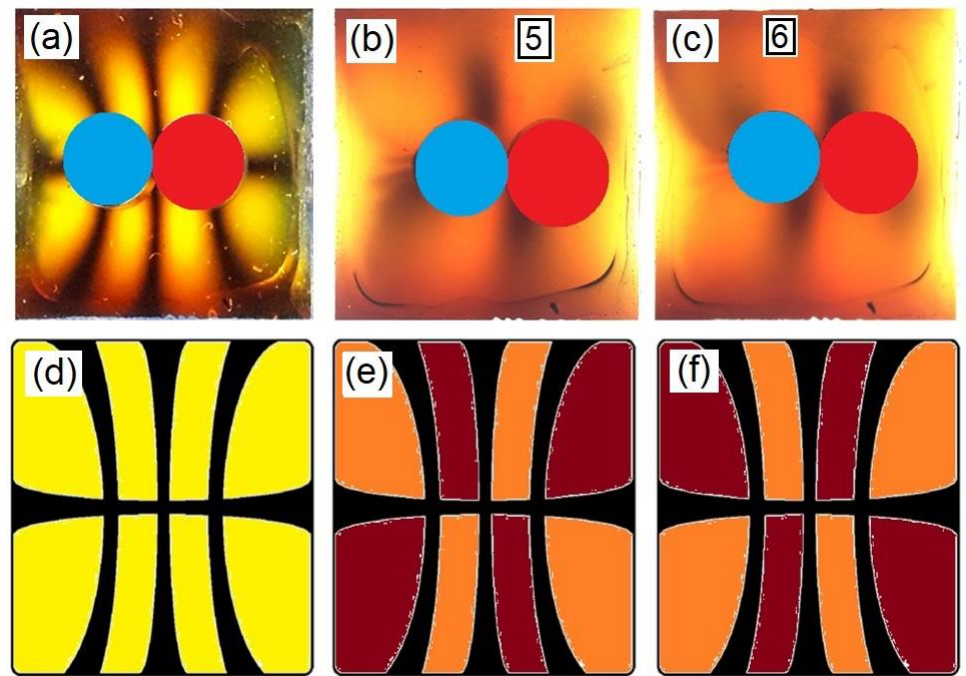
Figure 4. ( a ) Image of the linear polarization of a magnetic dipole. ( b ) Image of the polarization pattern of light with the same dipole, but with a linearly polarized light input and analyzed with a right-hand circular polarizer. ( c ) Image of the polarization pattern of light with the same dipole, but with a linearly polarized incoming light and analyzed with a left circular polarizer. In order to emphasize the polarization pattern, we have diagram ( d ) for the case shown in ( a ), the diagram in ( e ) for the case ( b ) and the diagram in ( f ) for the case in ( c ). Circular polarization patterns are complementary. With this experiment, we realized that the light that passes through the ferrofluid layer is partially polarized.